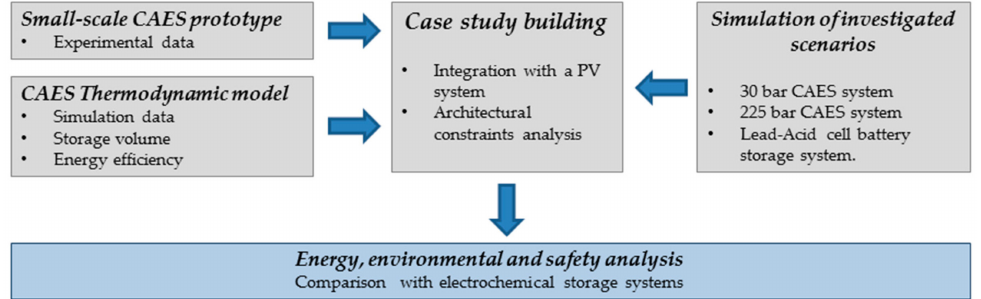
Figure 1. Flowchart with the steps of the research.